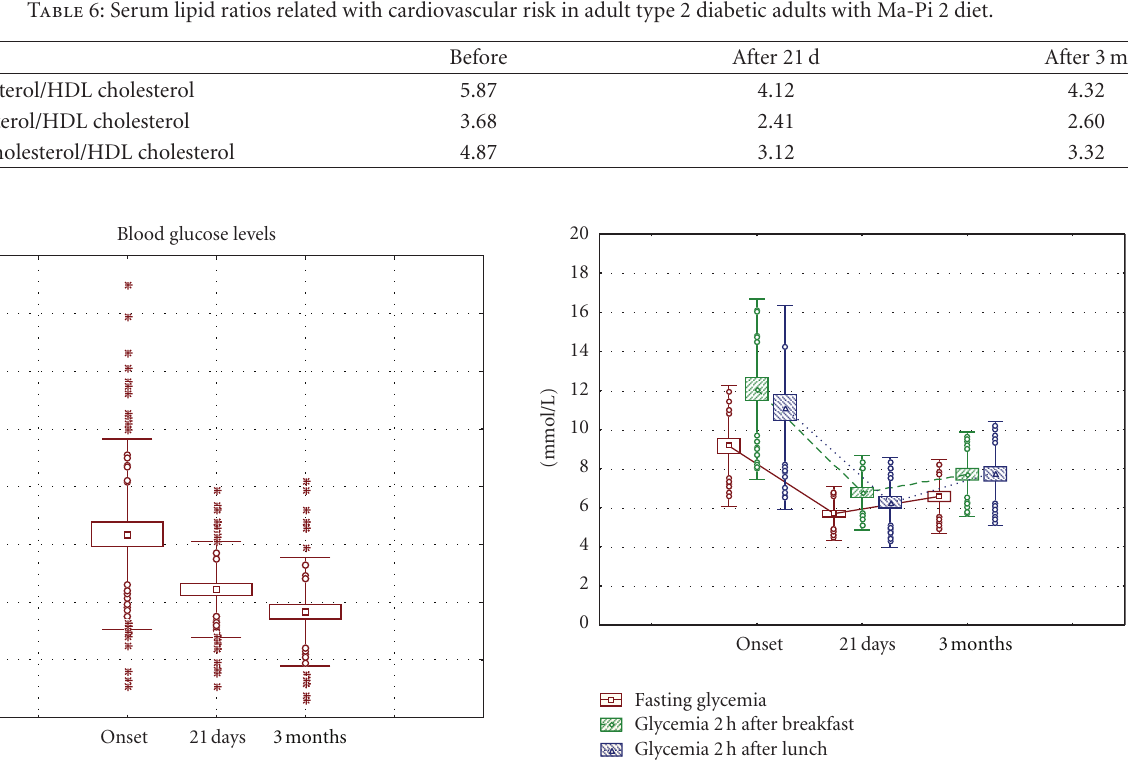
Figure 2: Glycemic profile evolution in type 2 diabetic adults with Ma-Pi 2 diet. Note: the figure shows the mean values (squares), individual distant values (circles), and individual extreme values (asterisks) at 3 times of the assay: at onset, 21 days and 3 months after intervention with the assayed diet. Mustaches represent the variation of the standard deviation and the biggest squares the variation of the standard error of the mean. Values are expressed in